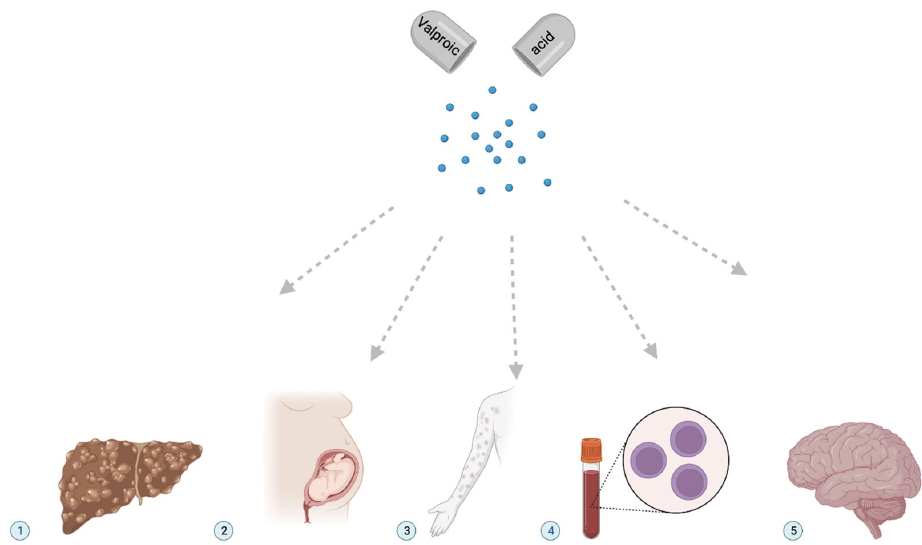
Figure 4. The most common clinical effects of toxic metabolites of valproic acid. Notes: (1) hepatotoxicity; (2) teratogenicity; (3) dermatitis, alopecia; (4) thrombocytopenia; (5) depression of the central nervous system.